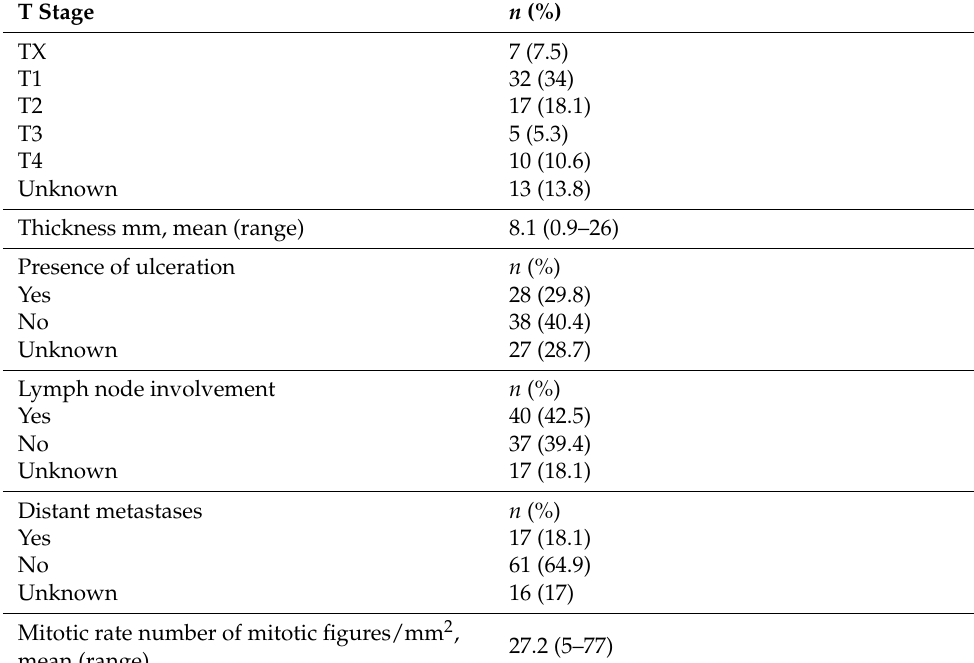
Figure 1. Distribution of the physicians who referred patients to the centers. In the majority of the patients with a measurable tumor and available T data, the maximum clinical tumor diameter was ≤ 2 cm (corresponding to T1) (Table 3). The mean tumor thickness was 8.1 mm (range: 0.7–26 mm); on average, patients had a mitotic rate of 27.2 mitotic figures per mm 2 . Among the patients for whom the chart information on the presence/absence of skin ulceration at the MCC site was available ( n = 66), 28 (42.4%) had ulcerations. During the development of the disease, lymph node involvement and distant metastases were reported in 42.5% and 20% of patients, respectively. Most patients (74/92, 80.4%) underwent surgery for tumor excision (of these, 13.5% (10/74) had affected margins), and the remaining patients (18/92, 19.6%) were subjected to a diagnostic biopsy. Table 3. Tumors’ characteristics (N = 94).